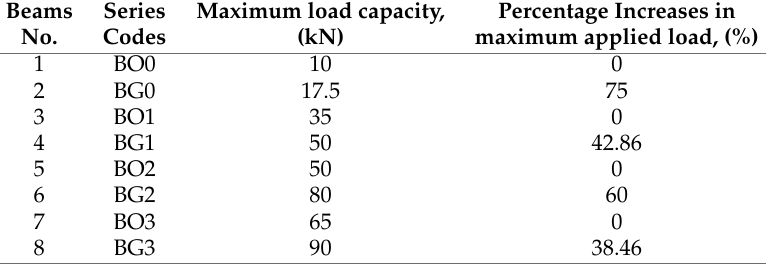
Table 5. Maximum Load Capacity for Beams Tested